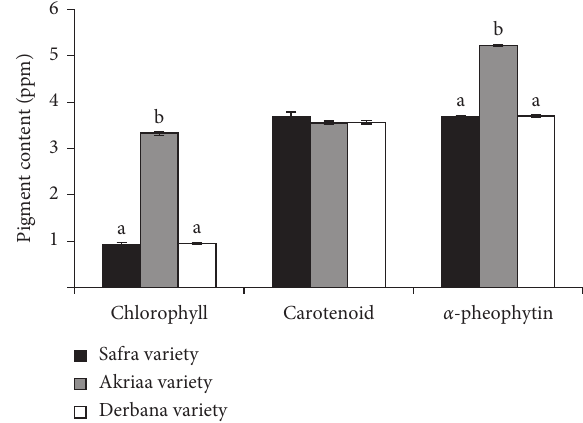
Figure 1: Chlorophyll, carotenoid, and α -pheophytin contents of seed oils of two prickly pear species: Opuntia ficus-indica (“Safra” and “Aakria” varieties) and Opuntia megacantha (“Derbana” va- riety). Means with the same letter for the same pigment did not differ significantly according to the Student–Newman–Keuls test at p < 0 . 05. Error bars represent the standard error of three